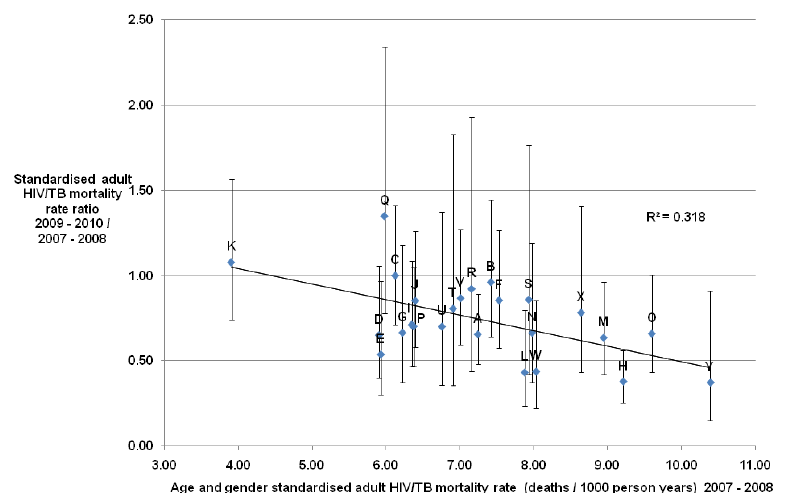
Figure 3. A comparison of the HIV/TB mortality rate ratios (with 90% confidence intervals) and mortality rates for 2007–2008 (points are labelled with the village codes).